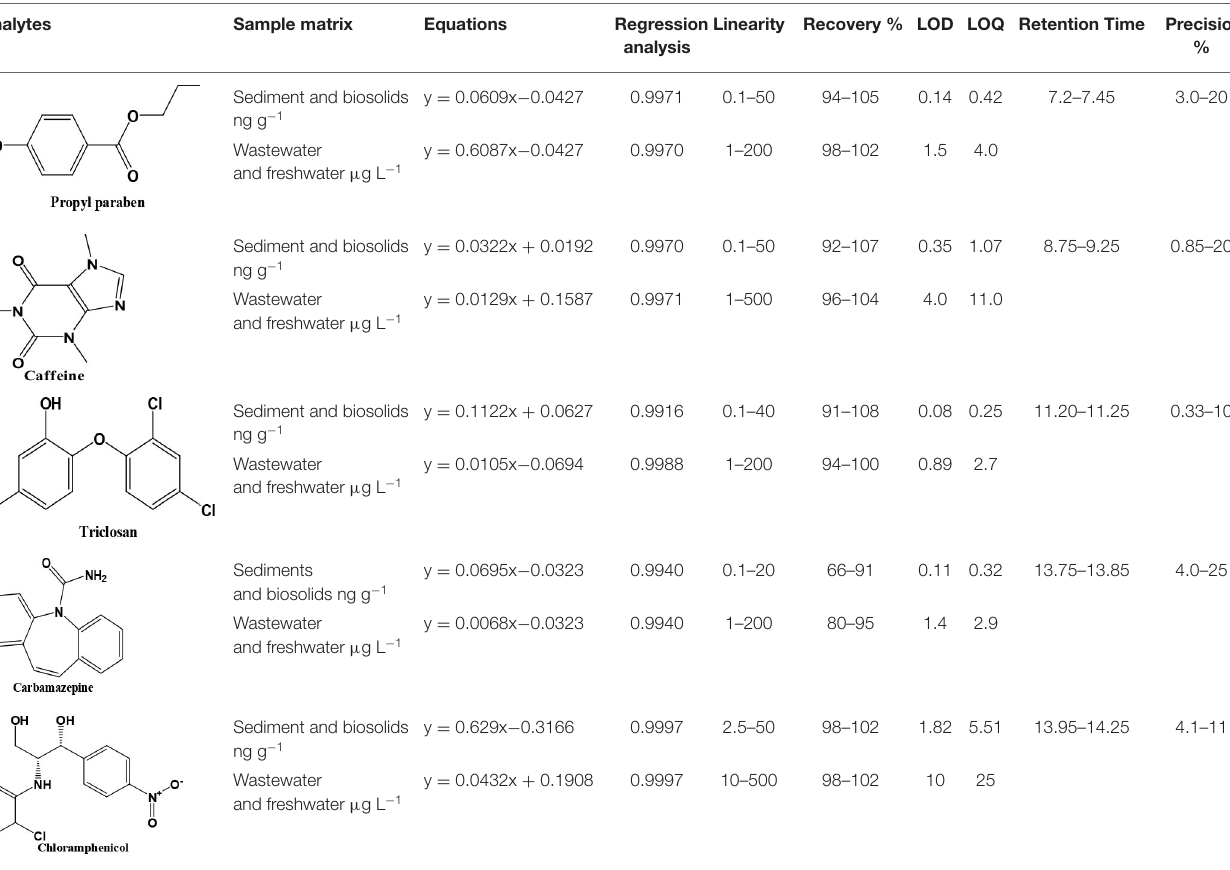
TABLE 1 | Validation data ( n = 3), retention time, calibration data, linearity, recovery, detection limits (LOD), quantification limits (LOQ), and repeatability of the studied compounds.